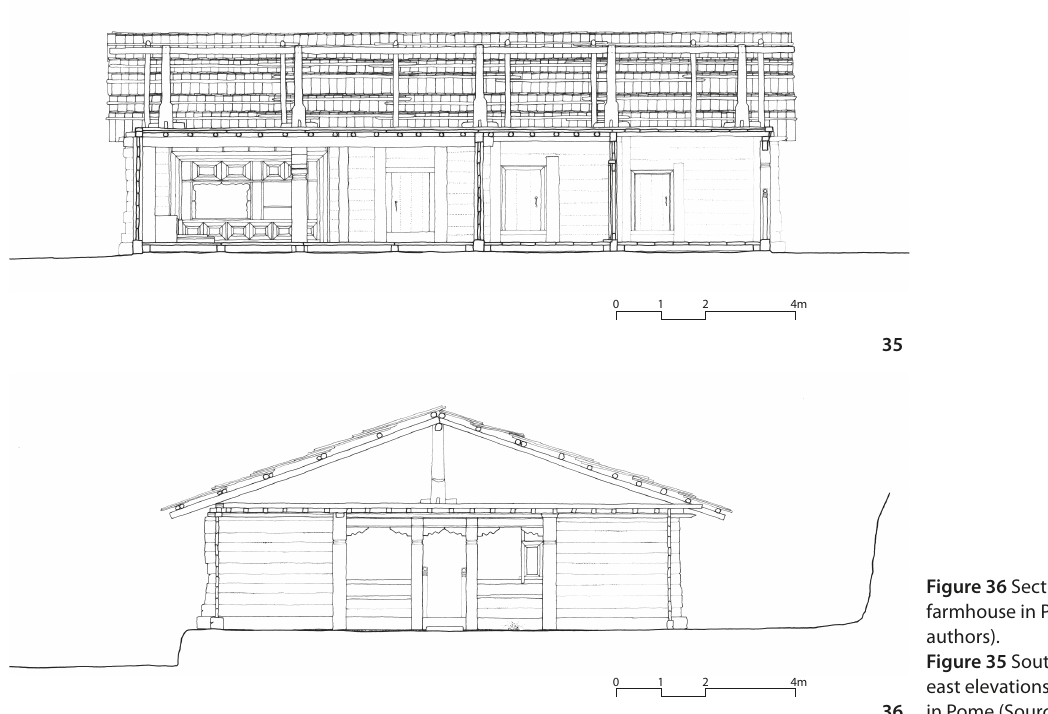
Figure 36 Section A-A of the farmhouse in Pome (Source: the authors). Figure 35 Southeast and north- east elevations of the farmhouse in Pome (Source: the